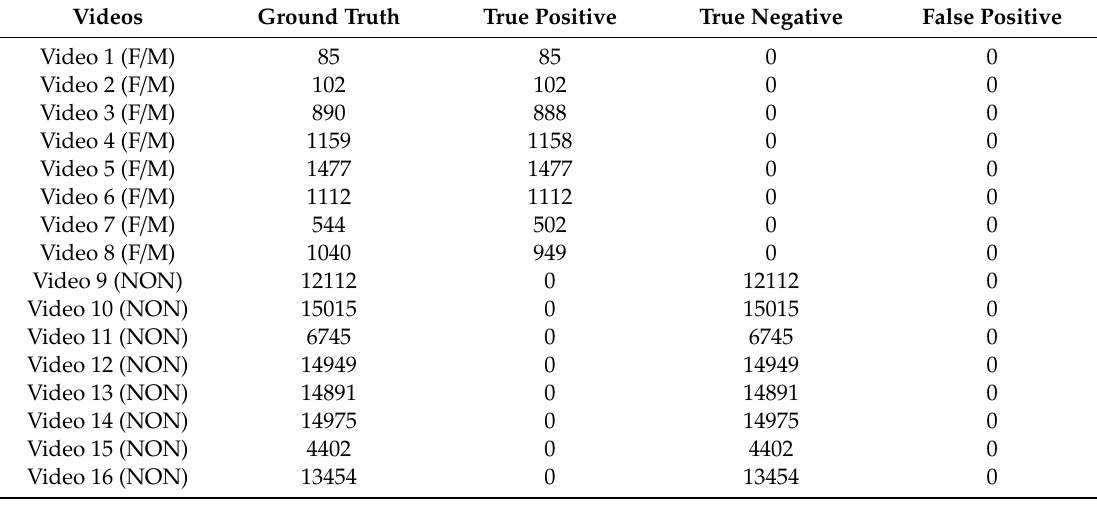
Table 2. The results of video test using proposed algorithm.